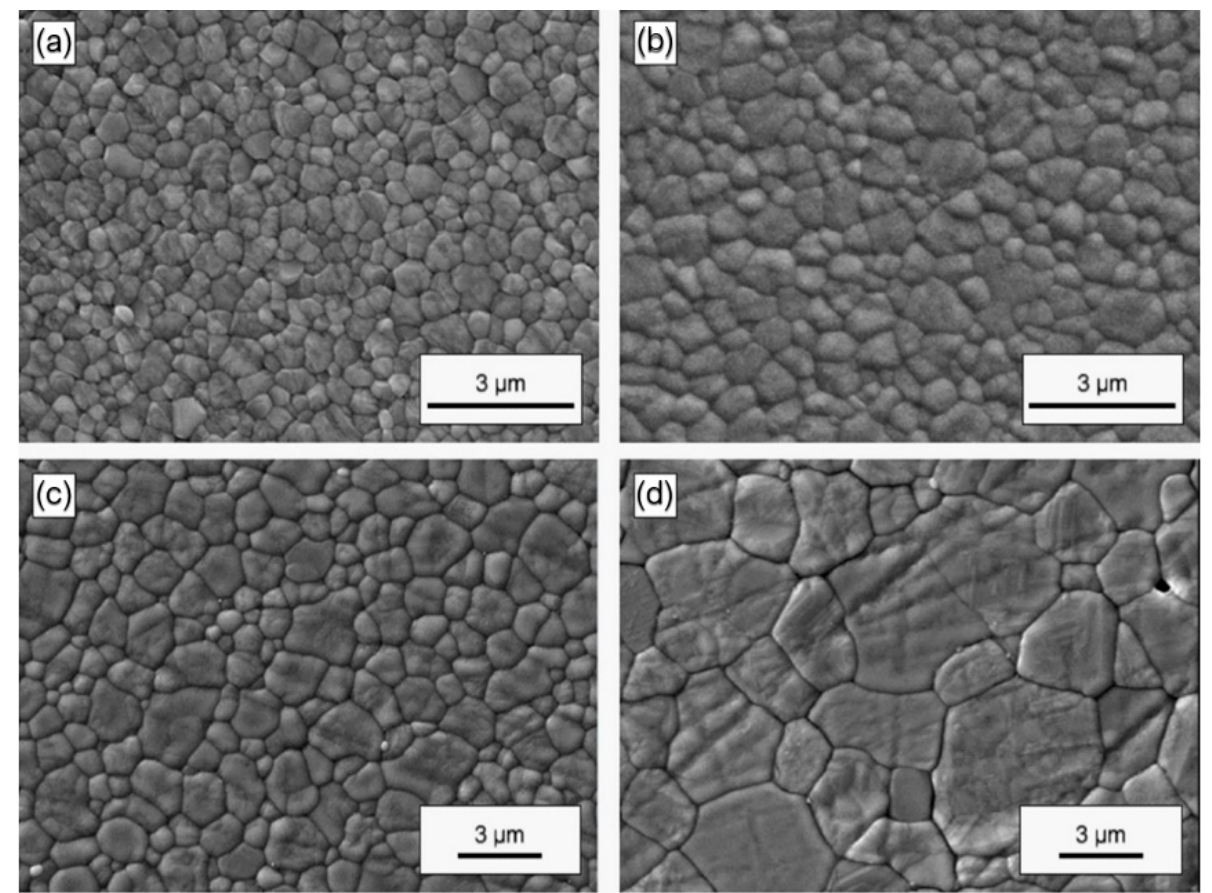
Figure 5. SEM micrographs of the Y-TZP samples sintered at different conditions: ( A ) 1475 °C for 2 h, ( B ) 1600 °C for 2 h, ( C ) 1600 °C for 12 h, and ( D ) 1600 °C for 24 h.